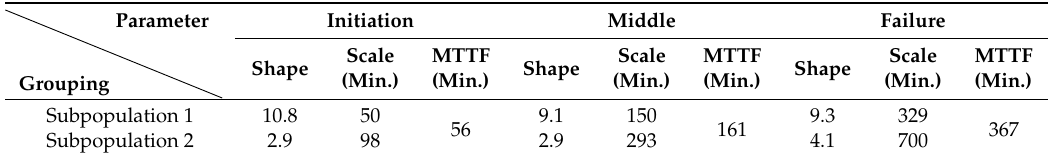
Table 6. Shape and scale parameter of tree model 3.